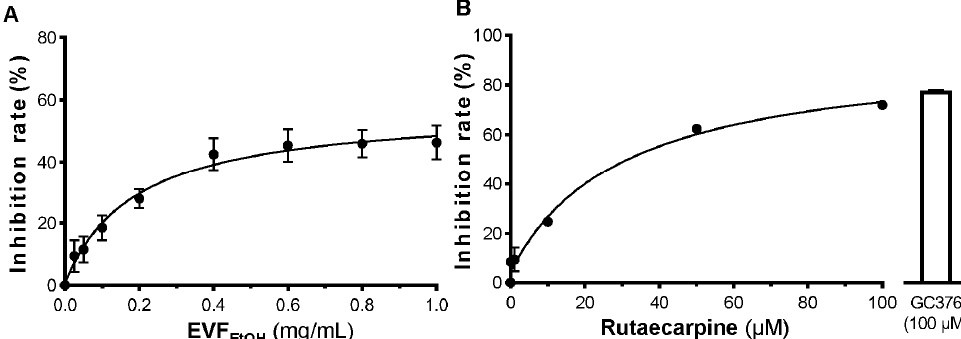
Figure 2. EVF EtOH and rutaecarpine inhibit 3CL protease activity. EVF EtOH ( A ) and rutaecarpin ( B ) both inhibited the activity of the enzyme in a dose-dependent manner. GC376 (100 µM) was used as a positive control. The data represent the mean ± SD percentage of inhibition to the control (with no drug treatment), and n = 4.